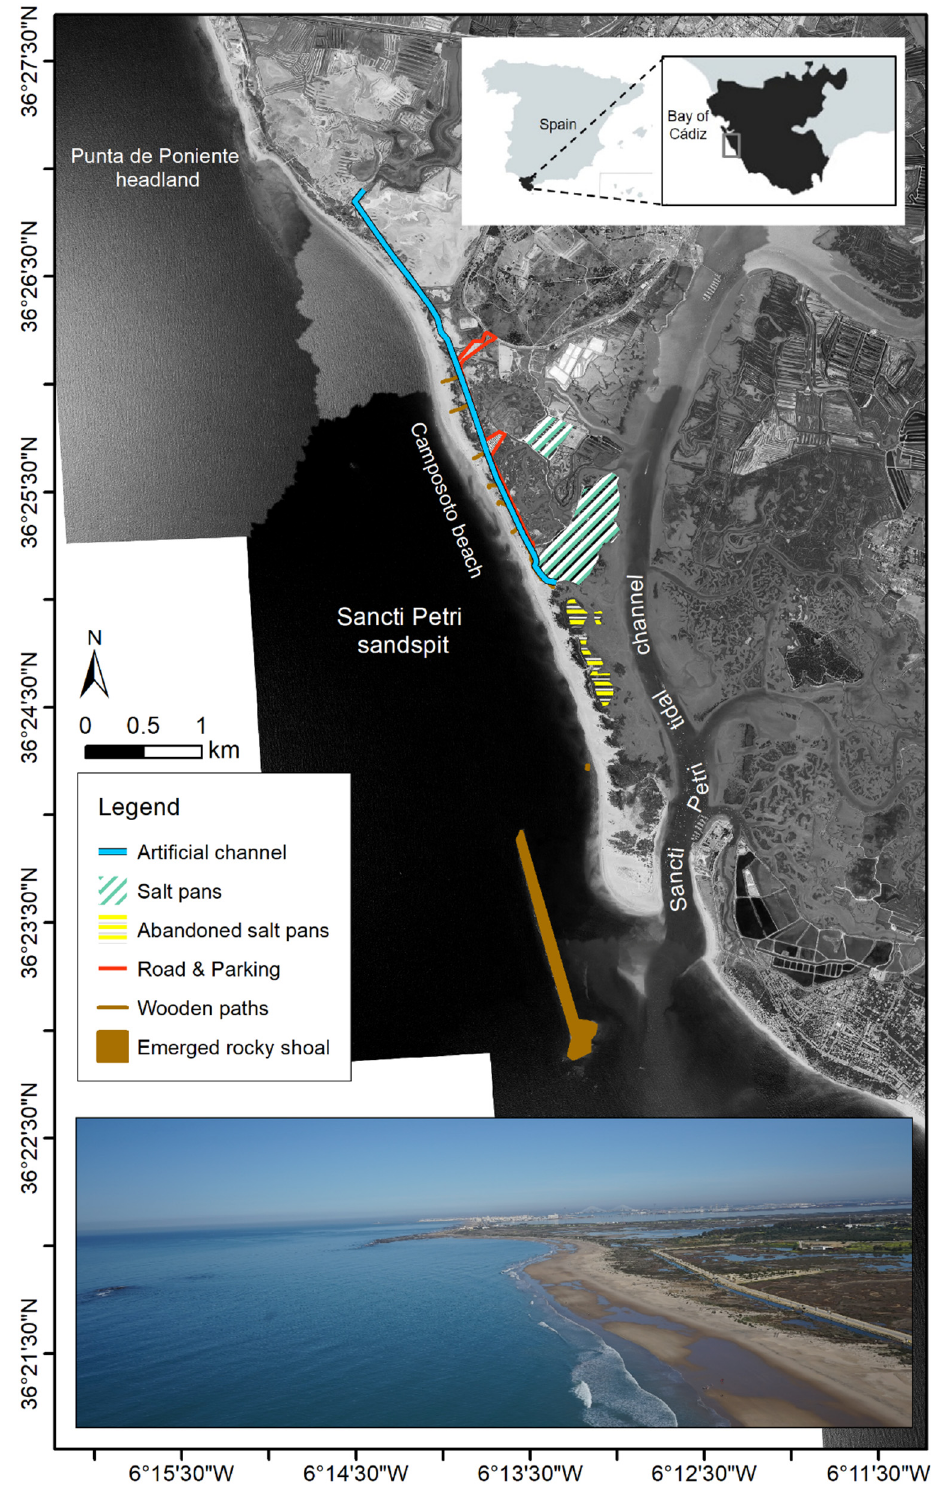
Figure 1. Location of the study site and a photograph showing Punta de Poniente headland as well as an emerged part of the rocky shoal during low